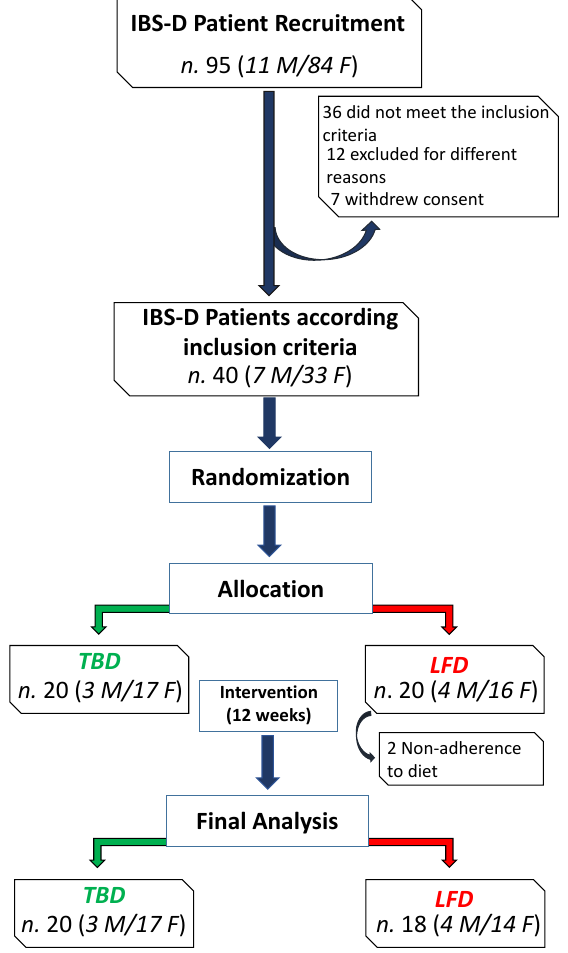
Figure 1. The CONSORT flowchart of the study. Abbreviations: IBS-D, irritable bowel syndrome with diarrhea; LFD, low-FODMAP diet; TBD, tritordeum-based diet.